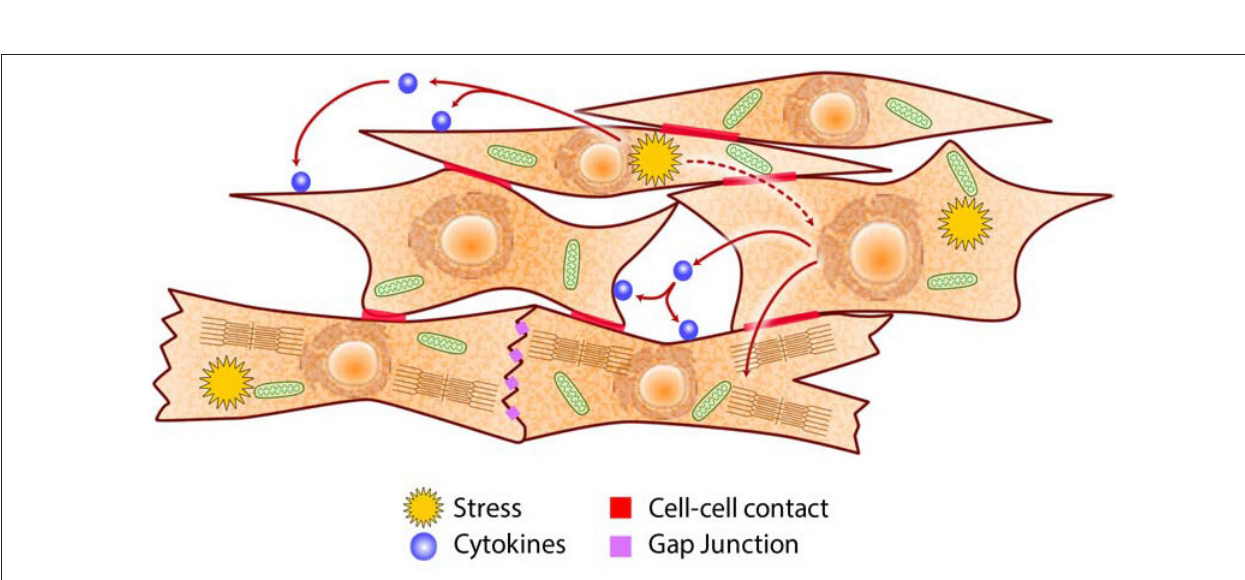
FIGURE 3 | Stress coping response mechanisms. Cellular organelles have resident stress coping response mechanisms that are designed to mitigate the impact of stress and minimize damage caused by stress. The unfolded protein response, oxidative stress response, and genome damage response mechanisms operate predominantly in the endoplasmic/sarcoplasmic reticulum (ER/SR), mitochondria, and nucleus, respectively.